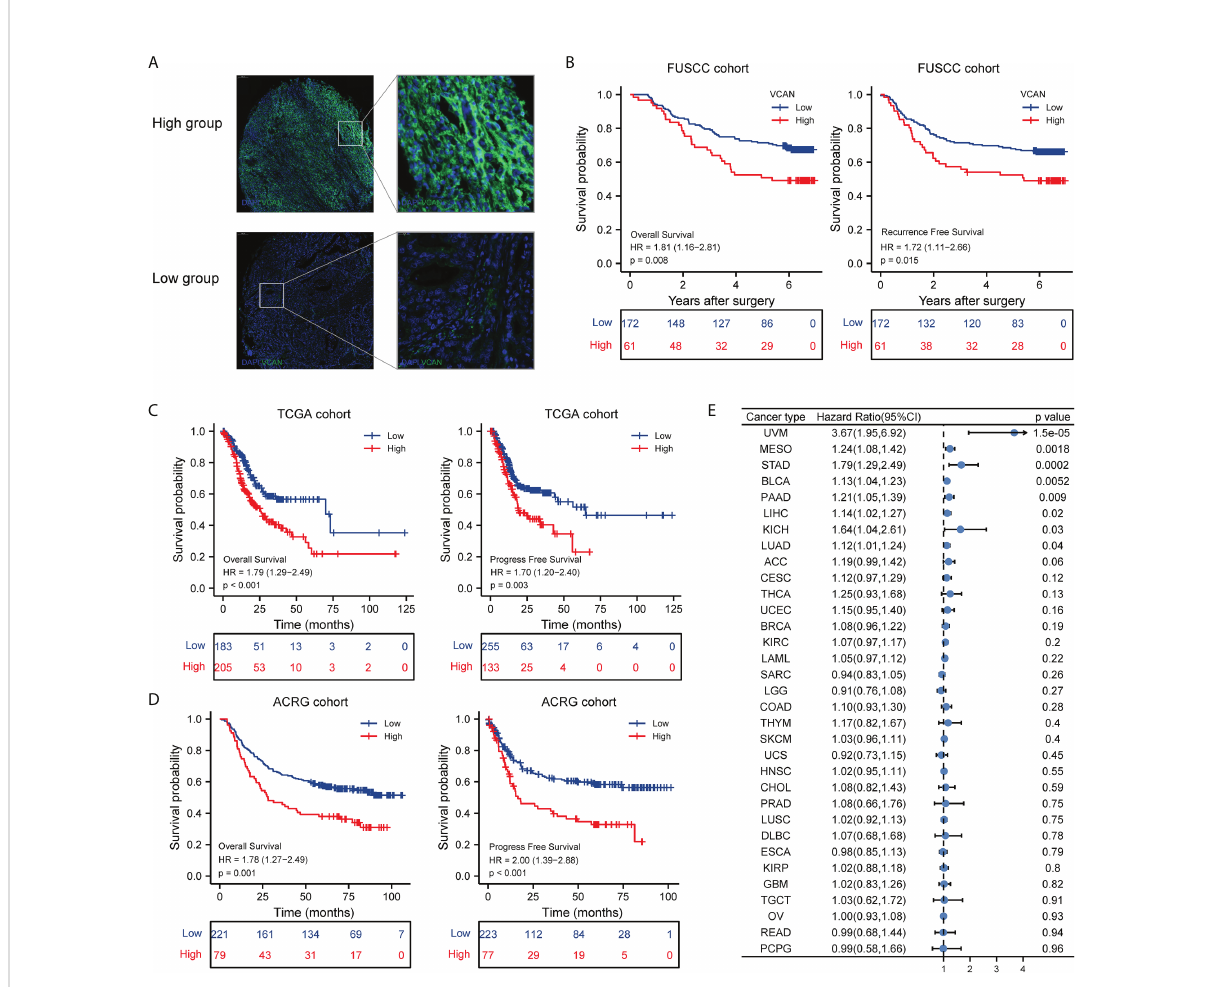
FIGURE 1 Correlation between VCAN expression and overall survival and progressive free survival. (A) Representative immuno fl uorescence images of the low VCAN group and high VCAN group in FUSCC cohort. (B) Kaplan – Meier curves of overall survival (OS) and recurrence free survival (RFS) of low VCAN and high VCAN group in FUSCC cohort. (C) Kaplan – Meier curves of OS and progress free survival (PFS) of low VCAN and high VCAN group strati fi ed in TCGA cohort. (D) Kaplan – Meier curves of OS and PFS of low VCAN and high VCAN group strati fi ed in ACRG cohort. (E) The correlation between VCAN expression with OS in human pan-cancer (Pan-cancer Atlas,